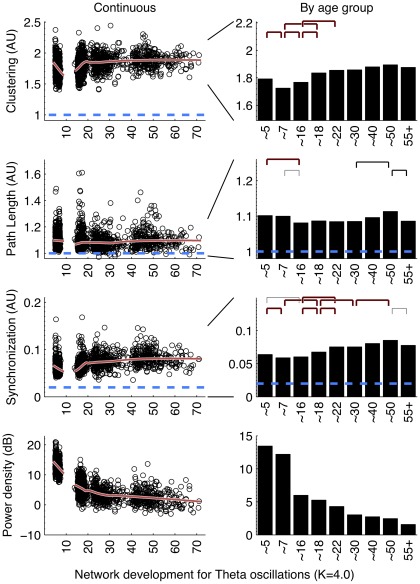
Theta oscillations (3.0–5.6 Hz) development of parameters C and L, average connectivity, and average power.See figure 2 for additional legend. (Left column:) Childhood ages showed elevated levels of all parameters including theta power. (Right column:) Bootstrapping showed significant increases between childhood and adolescence for C and SL. L and SL additionally showed an increase between ∼30 and ∼50 yrs, and a subsequent decrease to 55+.